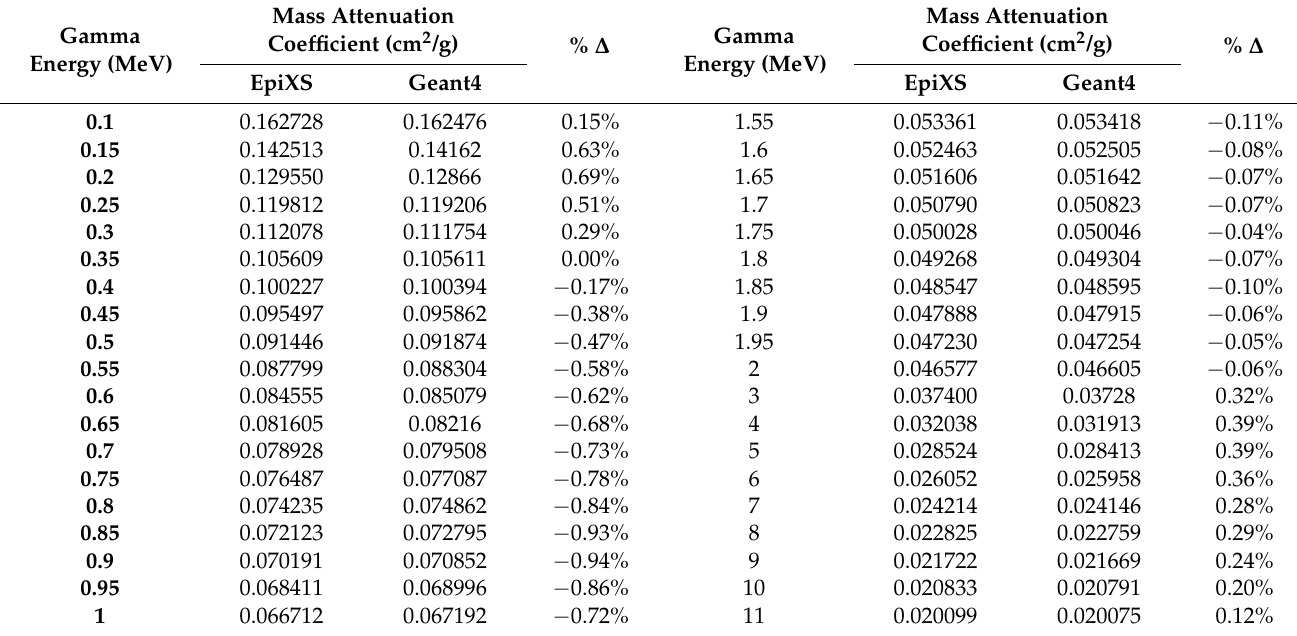
Figure 3. The mass attenuation coefficients of PSU at the investigated gamma energies using both Geant4 and EpiXS. Table 2. The mass attenuation coefficients of PSU in the investigated gamma energy